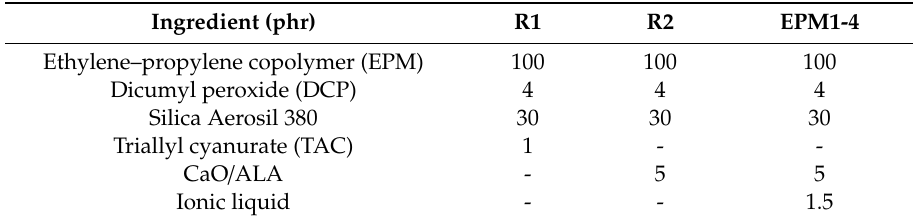
Table 3. General recipe of the ethylene–propylene copolymer (EPM) compounds, parts per hundred of rubber (phr) (R1 and R2 (benchmark samples); EPM1-4 (rubber compounds containing the ILs presented in Table